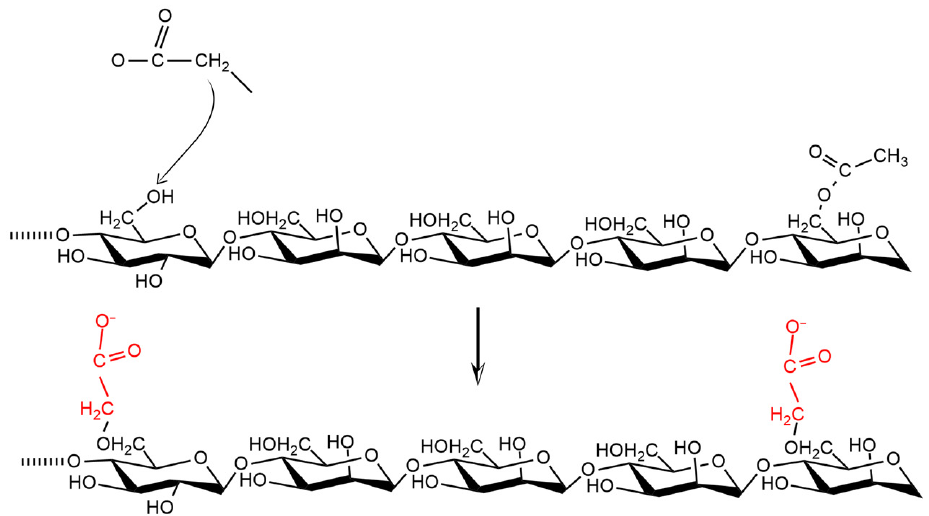
Figure 6. CMGM synthesis pathway.